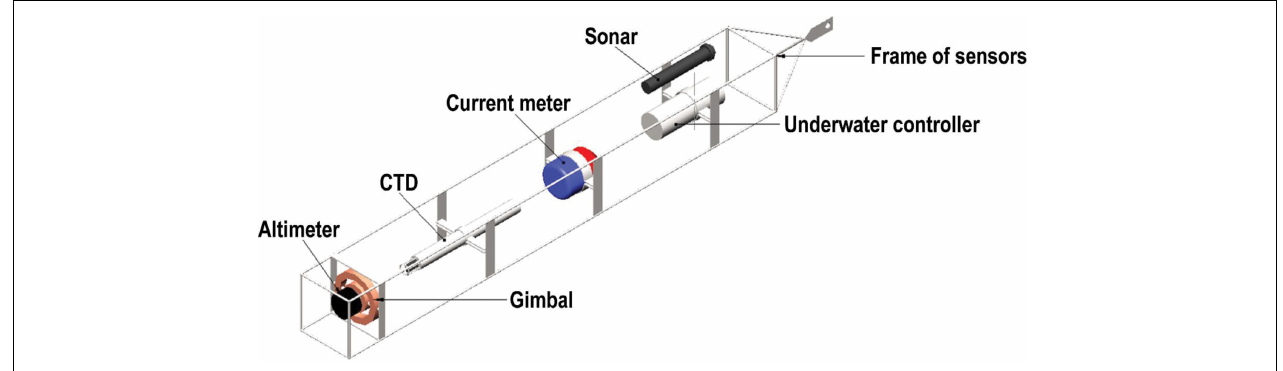
FIGURE 4 | Schematic of the frame marked in Figure 3 and the underwater sensors mounted in the